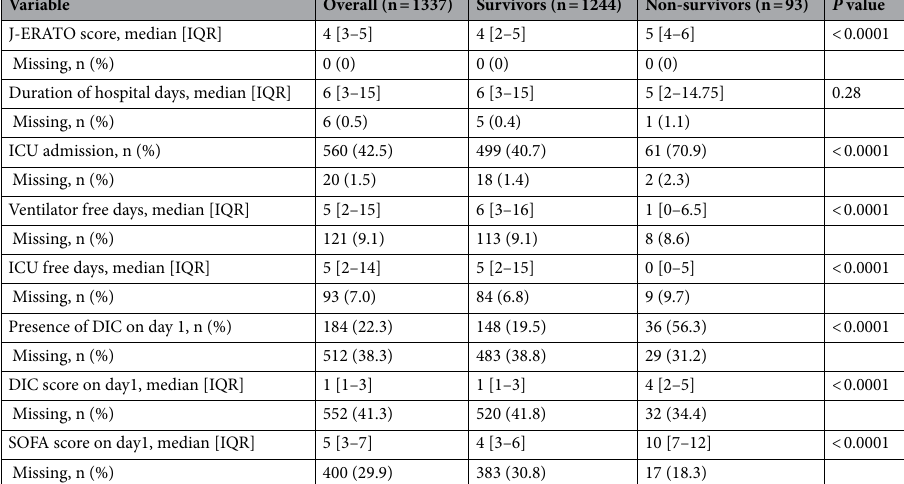
Table 2. Duration of hospitalization, outcomes, and severity scores between survivors and non-survivors. IQR, interquartile range; ICU, intensive care unit; DIC, disseminated intravascular coagulation; SOFA, sequential organ failure assessment.